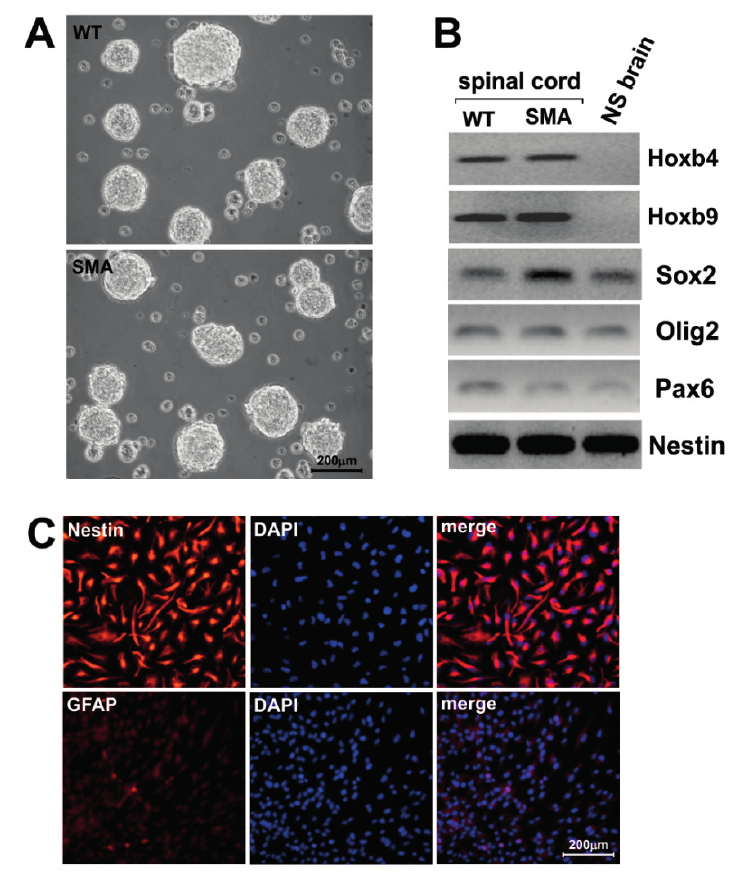
Figure 1. Characterization of NSCs (neural stem cells) derived from SMN Δ 7 SMA (spinal muscular atrophy) and WT (wild type) mice. Representative images of neurospheres isolated from spinal cord of E13.5 SMA and wild type mice, after 2 days of growth. Scale bar: 200 μ m ( A ); RT-PCR analysis of two relevant rostrocaudal markers, Hoxb4 and Hoxb9 , and a set of characteristic general markers of neural progenitors/radial glia ( Sox2 , Olig2 , Pax6 and Nestin ). The analysis has been performed on ten different animals per genotype and a representative sample for each is shown. The last lane on the right (NS brain) shows the results of the amplification of the same markers, performed on a mRNA sample extracted from neural stem cells derived from the brain of a WT littermate. Nestin was used as a loading control for all the RT-PCR amplifications ( B ); Representative images of immunocytochemical analyses of Nestin , a neural stem cell-associated marker on wild type NSCs. No signal for the astrocytic marker GFAP (glial fibrillary acidic protein) is present. Scale bar: 200 µm ( C